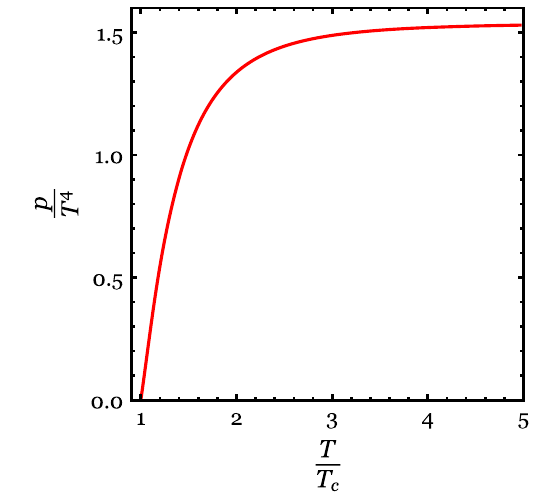
Fig. 2 The scaled pressure density p / T 4 as a function of scaled tem- perature T / T c with k = 0 . 43GeV and G 5 / L 3 = 1 . 26